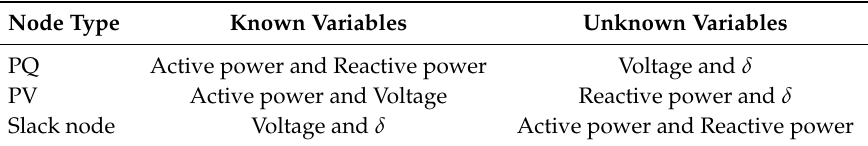
Table 7. Comparison between the network node types